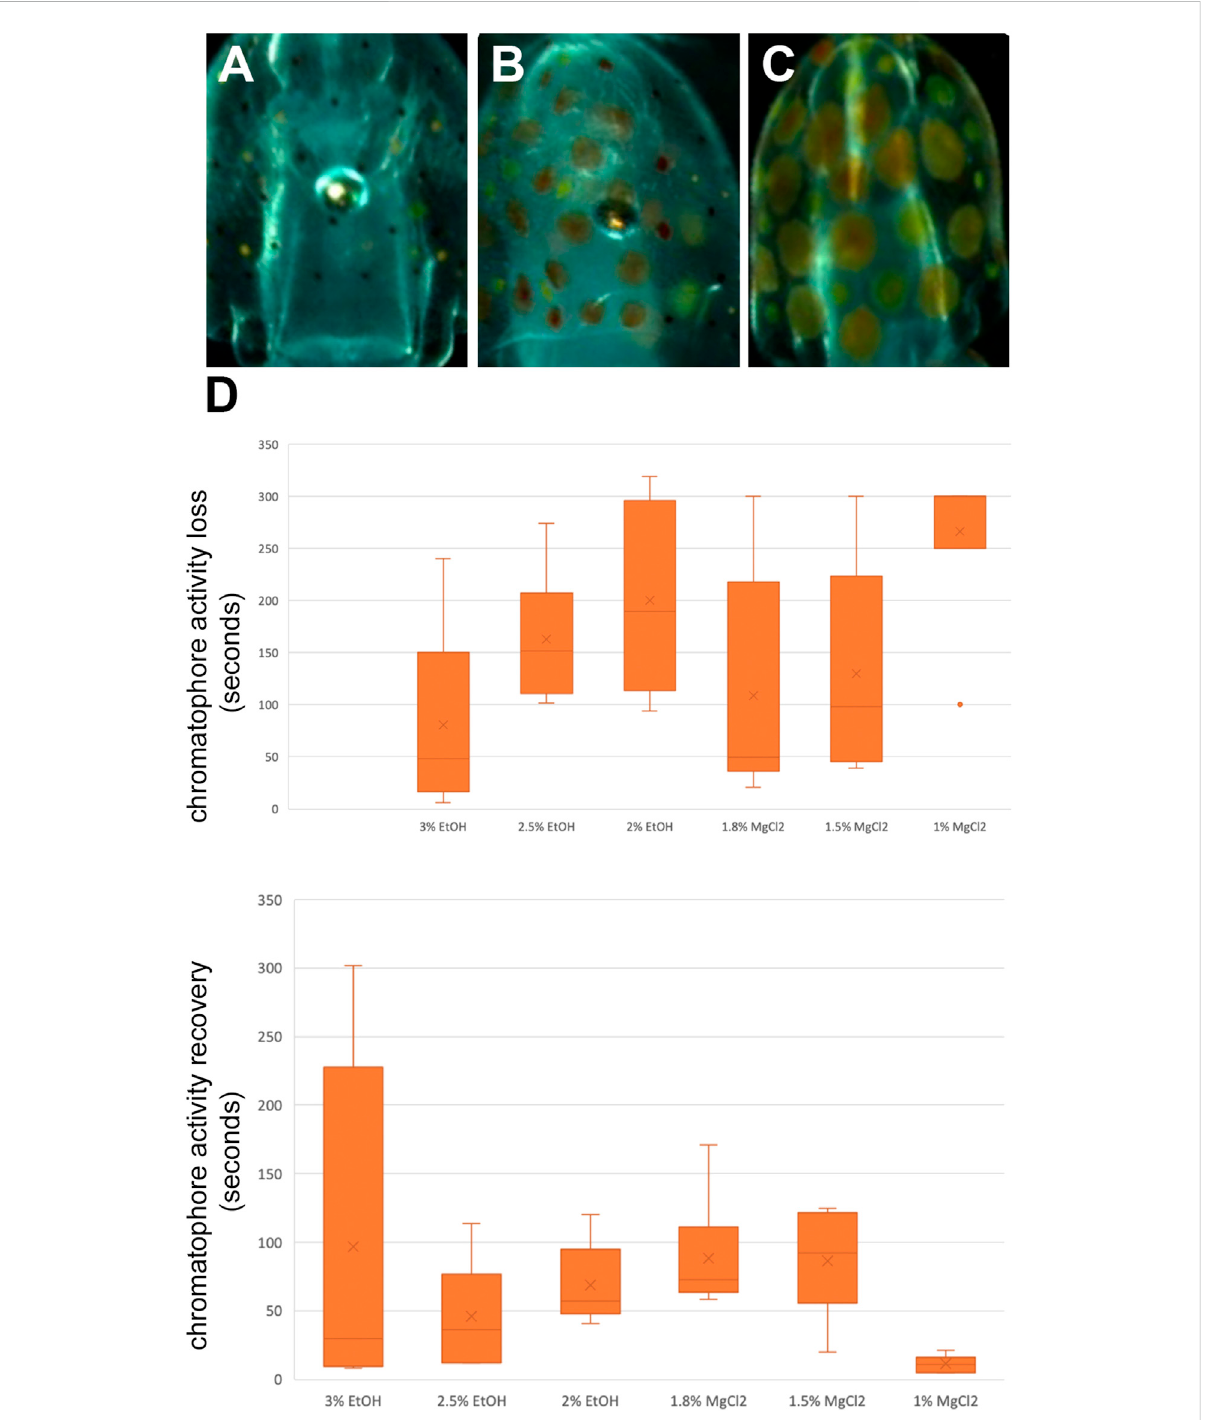
FIGURE 5 (A) Contracted chromatophores corresponding to muscle relaxation. (B) A half-contracted chromatophores. (C) Completely relaxed chromatophores corresponding to full muscle contraction. (D) Box and whiskers plot with the time until the loss or to recovery of chromatophores activity in seconds. The y-axis represents the seconds until the loss or to recovery of chromatophores and the x-axis displays the three EtOH and MgCl 2 concentrations. The upper and lower limits show the highest and lowest times, respectively, until loss or to recovery of chromatophore activity, and the mid-point shows the